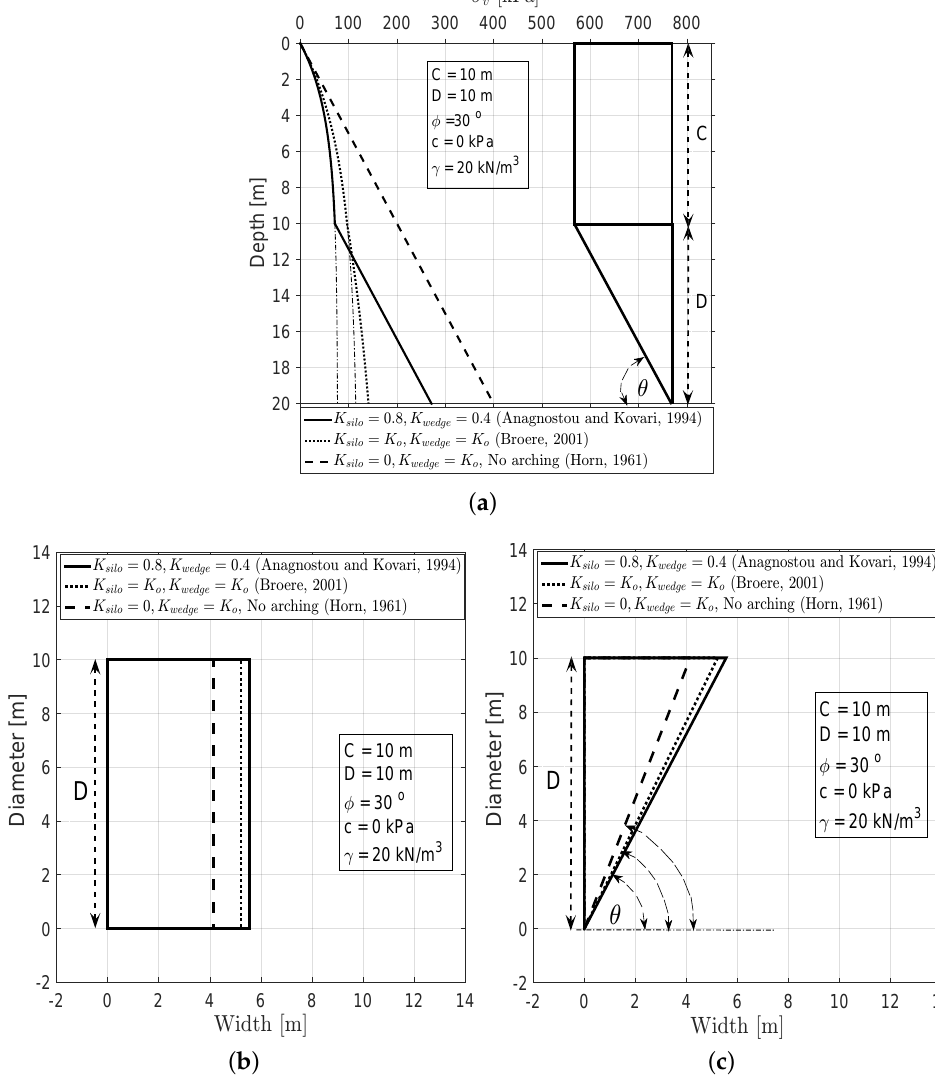
Figure 3. Vertical stress distribution for different arching implementations ( a ) Vertical stress distribu- tion ( b ) Top view of failure mechanism ( c ) Side view of failure mechanism.